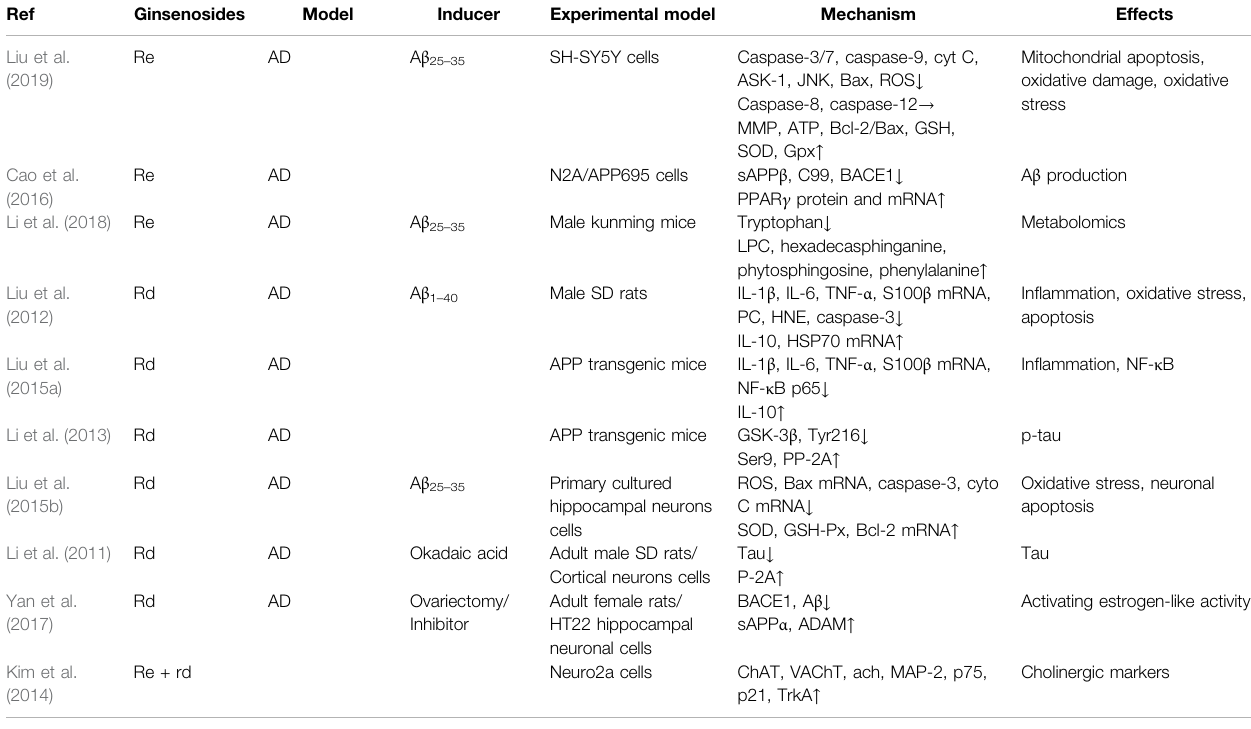
TABLE 1 | ( Continued ) Summary of effects and mechanisms of ginsenosides in neuronal cells and animal models.